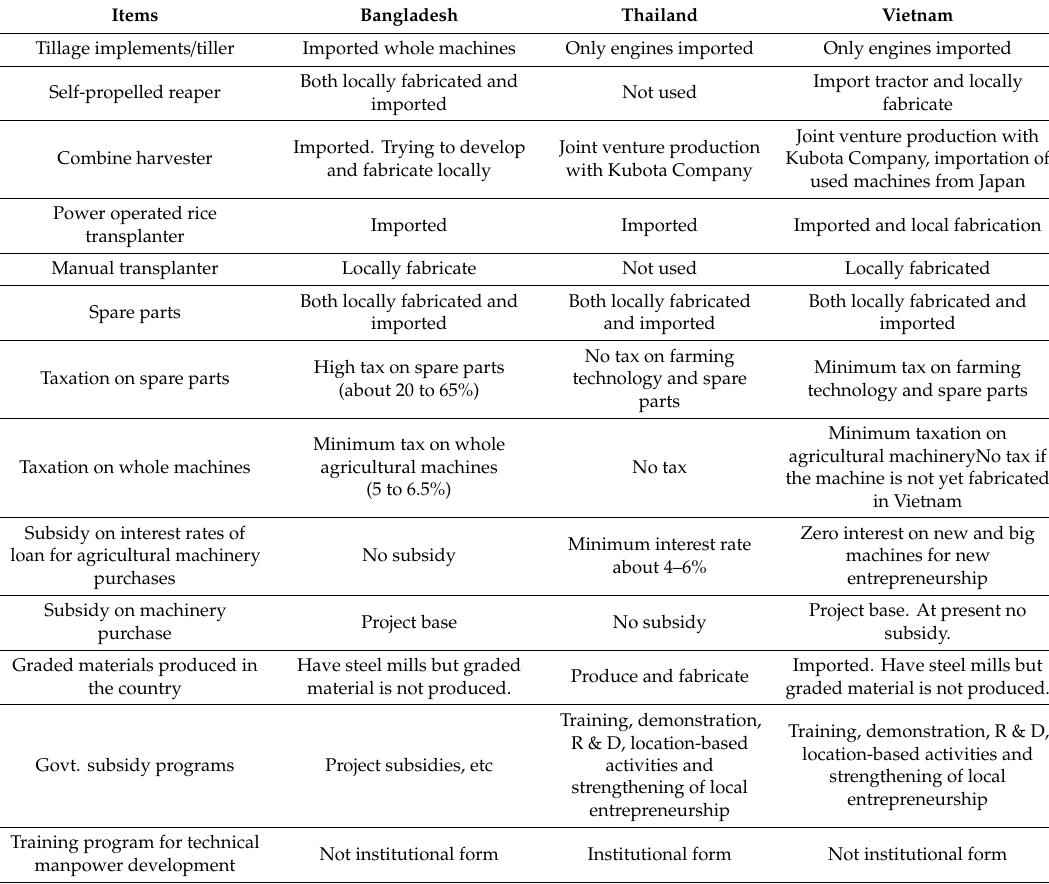
Table 4. Comparative policy / strategy